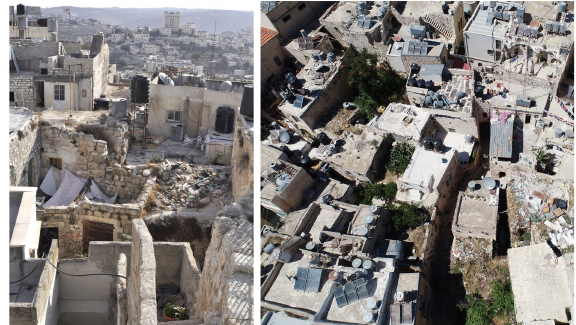
Figure 3: Landfills on roofs and